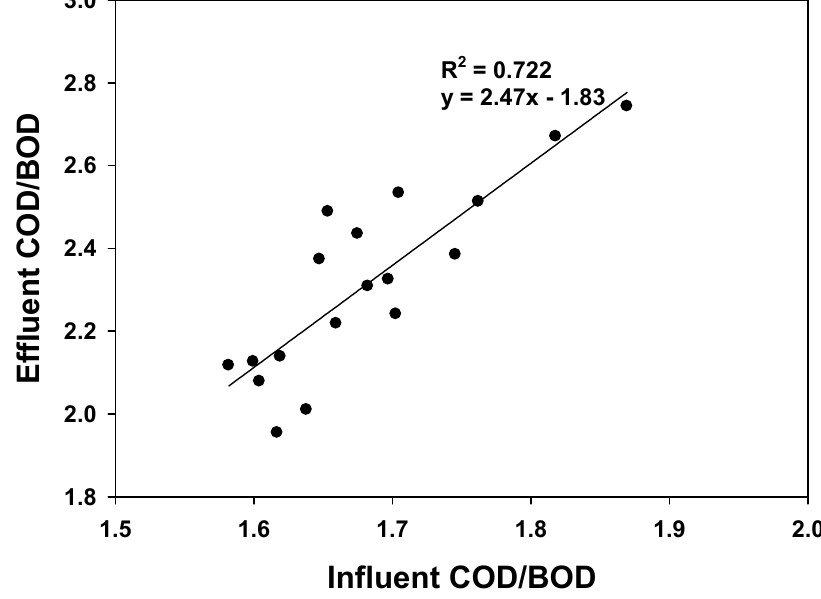
Figure 5. Comparison of influent COD/BOD ( x -axis) to effluent COD/BOD ( y -axis).